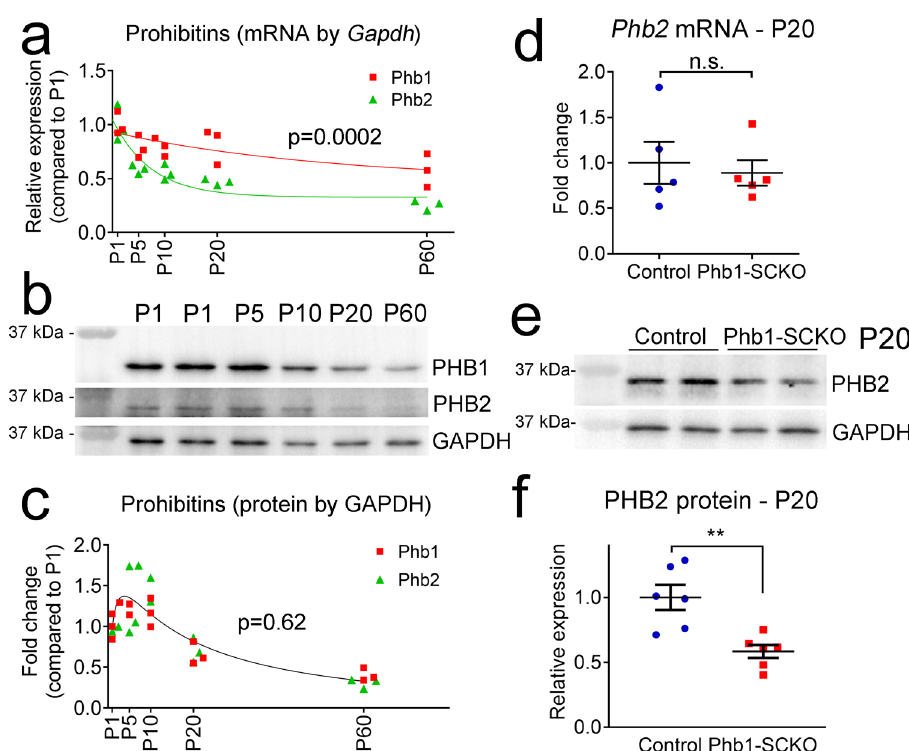
Fig. 1 A progressive demyelination and axonal degeneration affect Phb1-SCKO animals. a Schematic representation of the fl oxed Phb1 allele. Exons 4 and 5 of the Phb1 gene are deleted upon Cre expression. Primers p1 and p2 were used for genotyping, while primers p1 and p3 were used to evaluate recombination. Square (exon), triangle (loxP site), blue half-arrow (primer). b Recombination PCR on DNA isolated from sciatic nerves reveals a ∼ 260 bp recombined band in Phb1-SCKO animals, while unrecombined DNA is too long to generate an amplicon with our PCR conditions. The